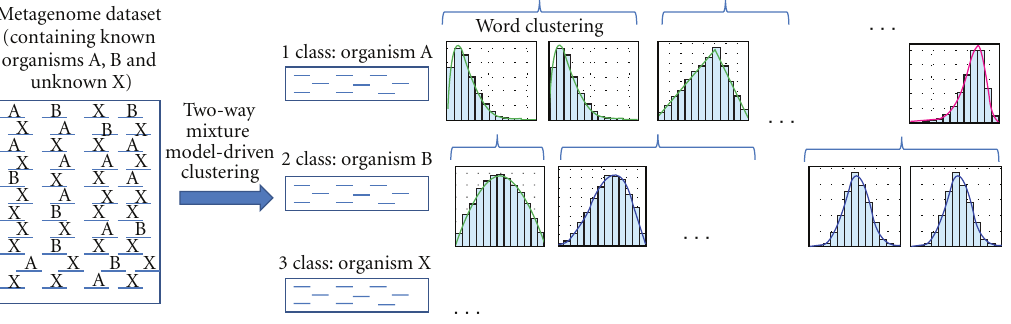
Figure 2: Illustration of a two-way Poisson mixture model for metagenomic data. Each cluster represents a species and is modeled as a distribution of words comprising it. Each word follows a di ff erent distribution. However, not all words in a class have significantly di ff erent parameters. Therefore, the words can be divided into groups and words within the same group can be constrained to have identical